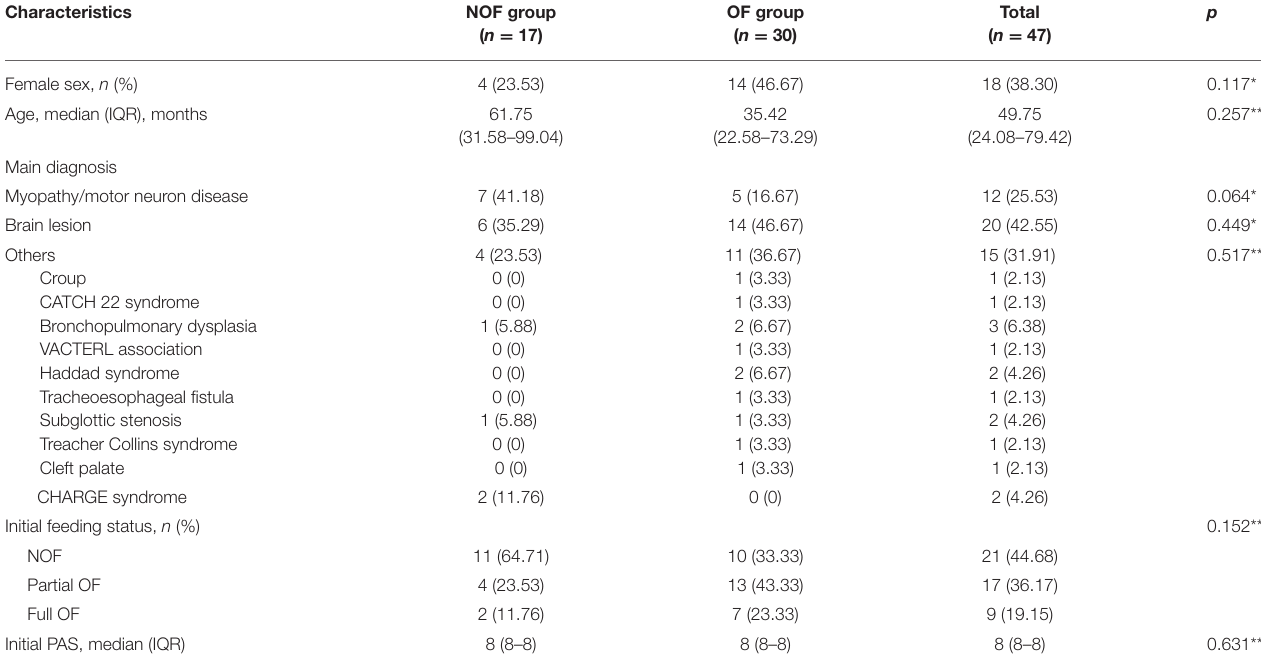
TABLE 1 | Characteristics of subjects at the time of the videofluoroscopic swallowing study. Characteristics